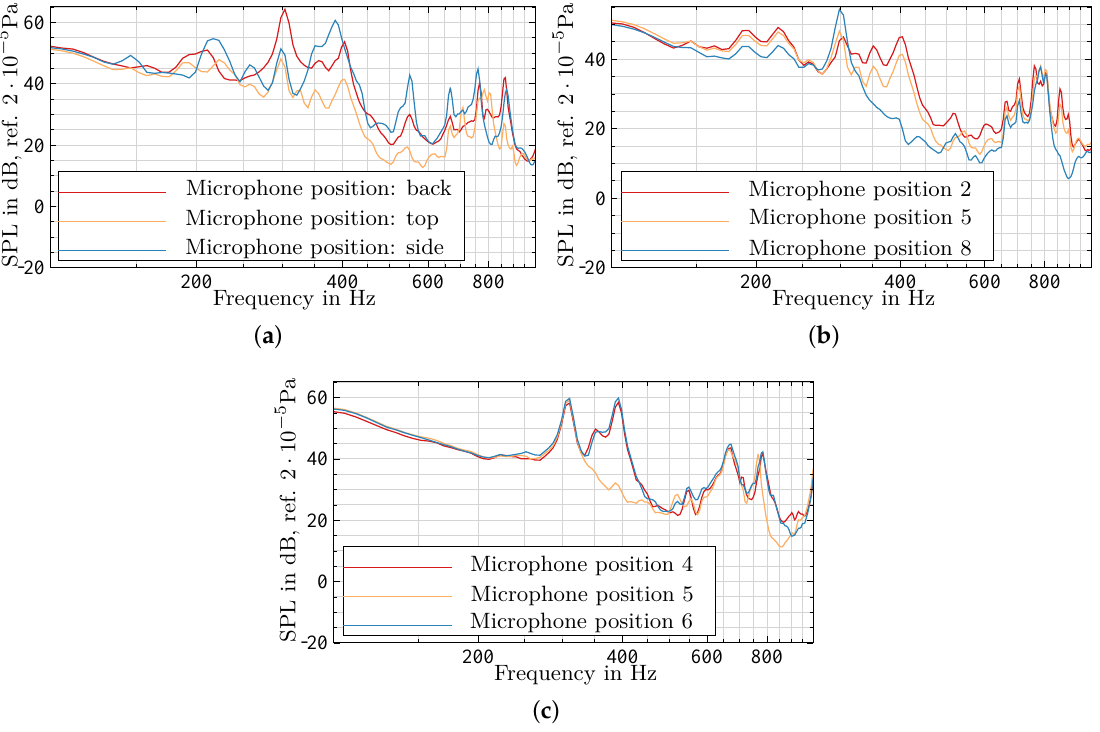
Figure 11. Sound Pressure Level at variation of the microphone position (plate thickness t = 1mm). ( a ) Different measuring surfaces; ( b ) On the cover panel in z -direction; ( c ) On the rear panel in x -direction (minimum